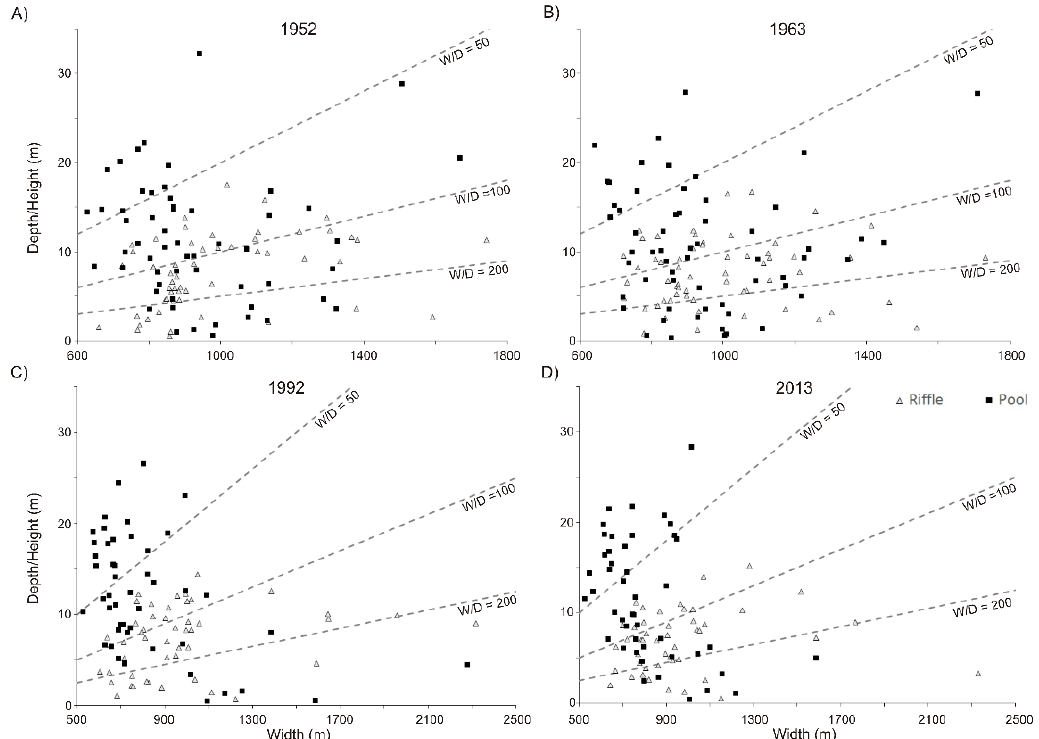
Figure 13. The W/D ratio for the lower reach at four different times: 1952 ( A ), 1963 ( B ), 1992 ( C ), and 2013 ( D ). All the descriptions are the same as Figure 12.